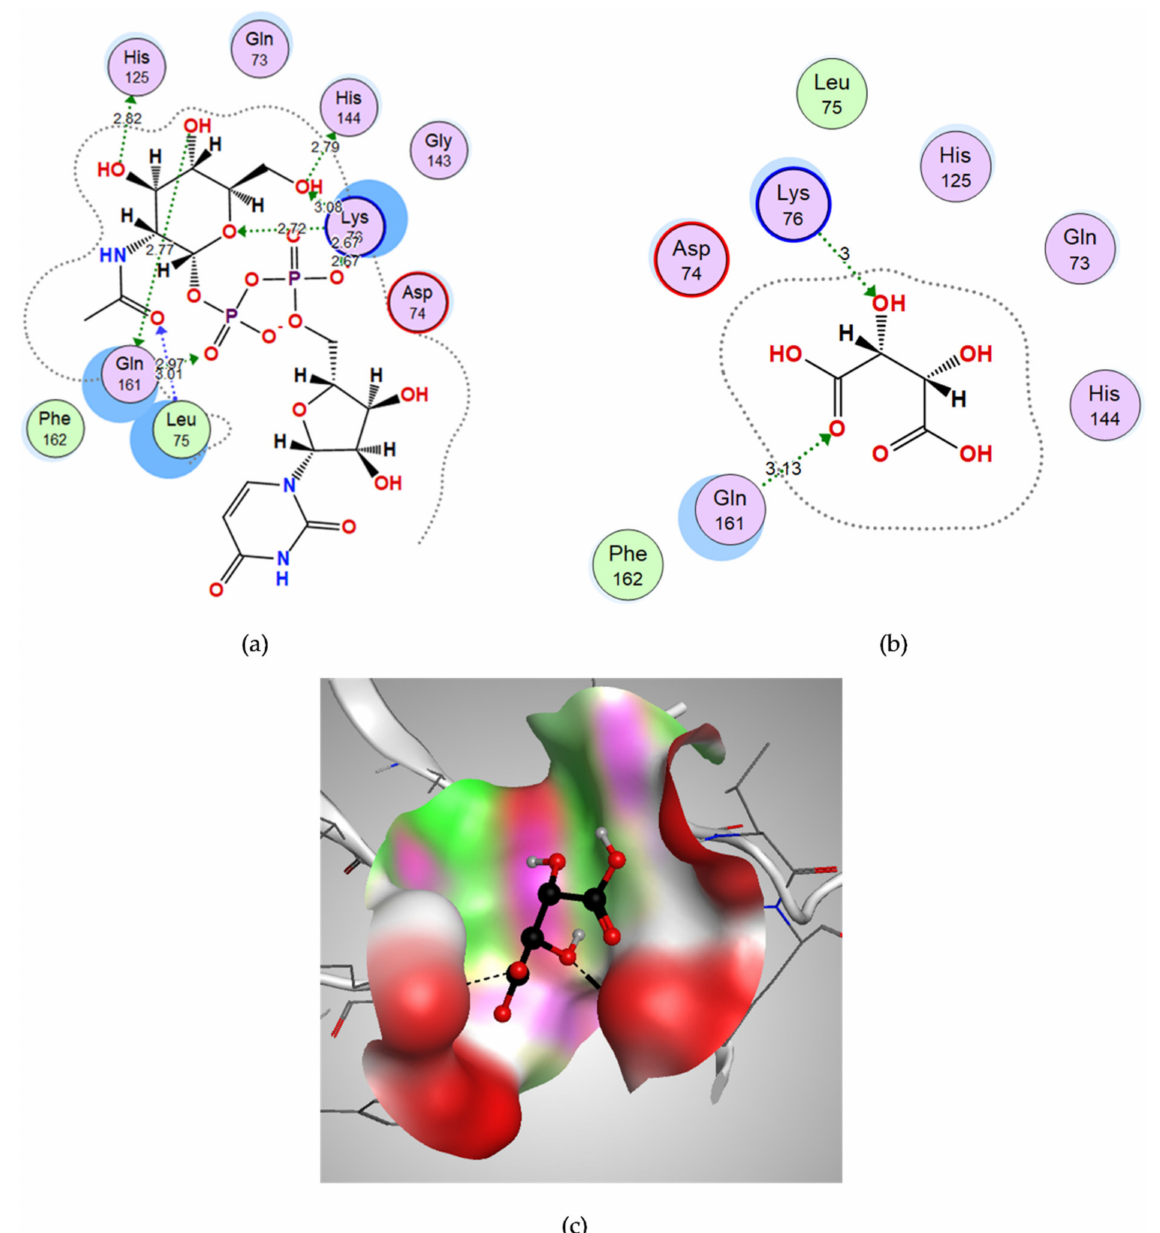
Figure 6. The molecular docking study of UDP-N-acetylglucosamine acyltransferase (LpxA) with the co-crystalized ligand Uridine-Diphosphate-N-Acetylglucosamine (UD1) and the candidate ligand D-tartaric acid: ( a ) Two-dimensional interactions of the co-crystalized ligand UD1 within the LpxA active site; ( b ) Two-dimensional interactions of D-tartaric acid within the LpxA active site; ( c ) Three- dimensional interactions of D-tartaric acid within the LpxA active